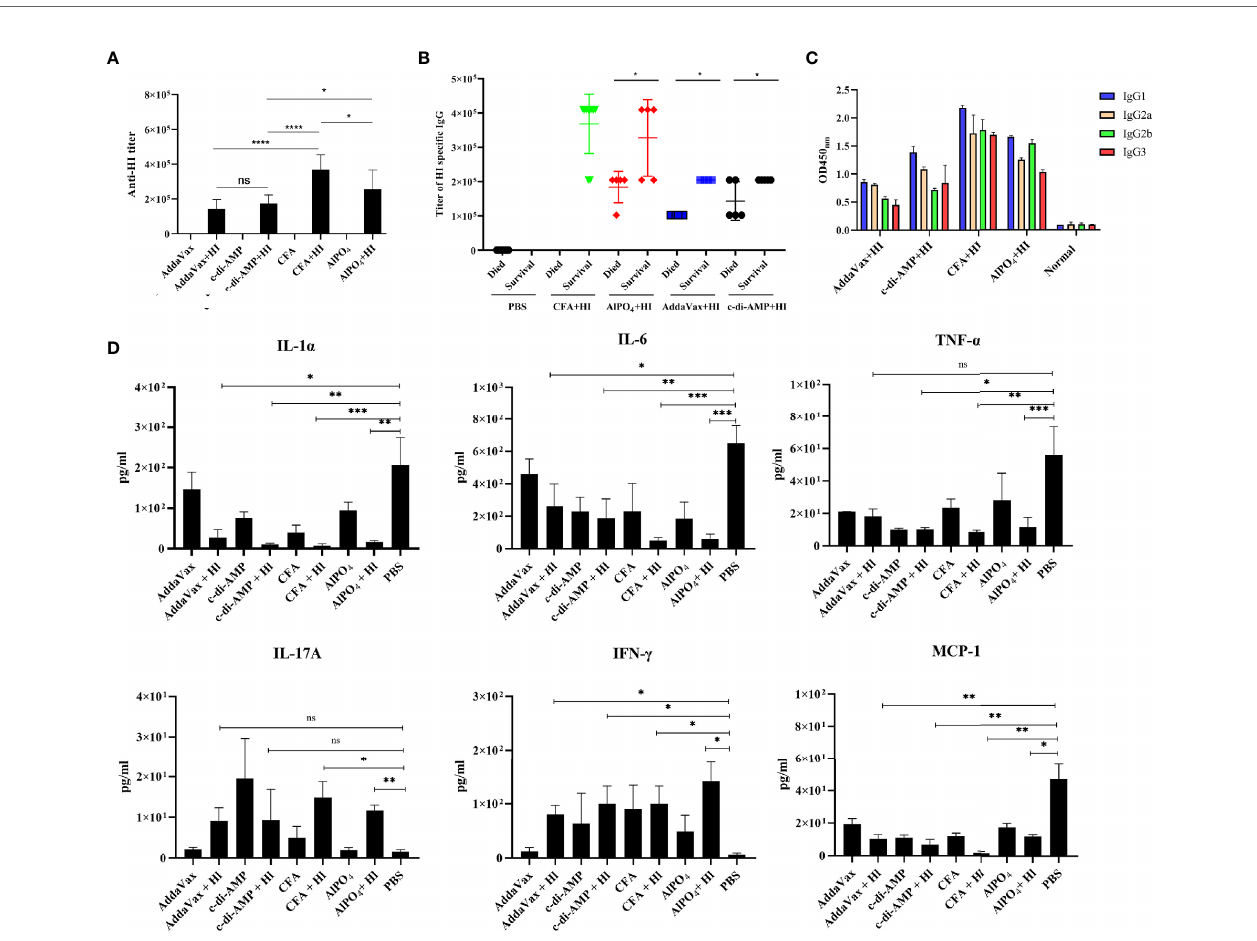
FIGURE 2 | HI-speci fi c antibody and cytokine production in response to MRSA252 challenge. (A) Antibody production in mice immunized with HI plus different adjuvants, adjuvants alone, or PBS alone. (B) Correlation between the titer of HI-speci fi c IgG and the survival of each immunized mouse (n=10). (C) HI-speci fi c antibody isotope analysis in mice immunized with HI plus different adjuvants, adjuvants alone, or PBS alone. Results are representative of three experiments, and data are shown as the mean ± SD of samples from 10 mice. (D) Cytokine analysis in the sera of immunized mice after challenge with MRSA252. Serum samples were collected 48 h after infection (n = 8). ns, not signi fi cant; *p < 0.05, **p < 0.01, ***p < 0.001, ****p <